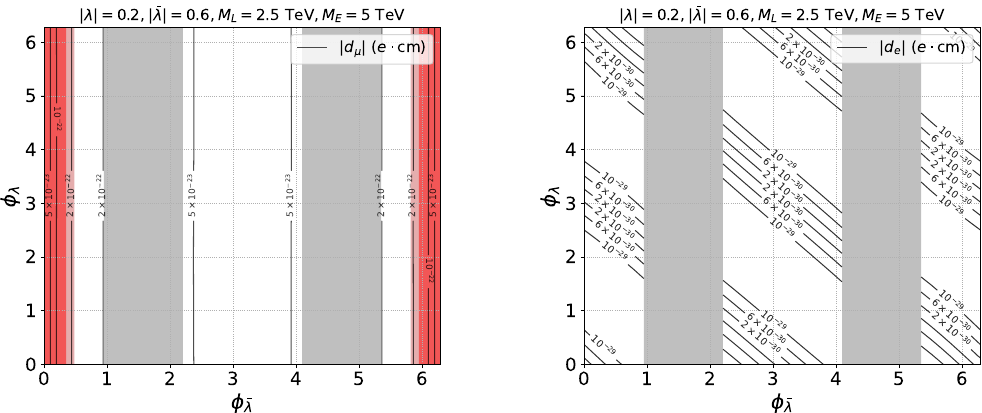
Figure 6 . The dependence of muon EDM (left) and electron EDM (right) on the two CP - violating phases in the model. The other parameters are chosen to be | λ | = 0 . 2 , | ¯ λ | = 0 . 6 , M E = √ √ 2 . 5 TeV , M L = 5 TeV , λ L = − 0 . 04 × 2 M L /v ∼ − 0 . 57 , and λ E = 0 . 03 × 2 M E /v ∼ 0 . 86 . The size of the EDMs are given by the black contours. The gray bands represent the regions where no solution exists for the y µ to give the correct muon mass after the mass diagonalization. The region consistent with muon g − 2 at (2 σ ) 1 σ level is also indicated in the left figure by the (light) red